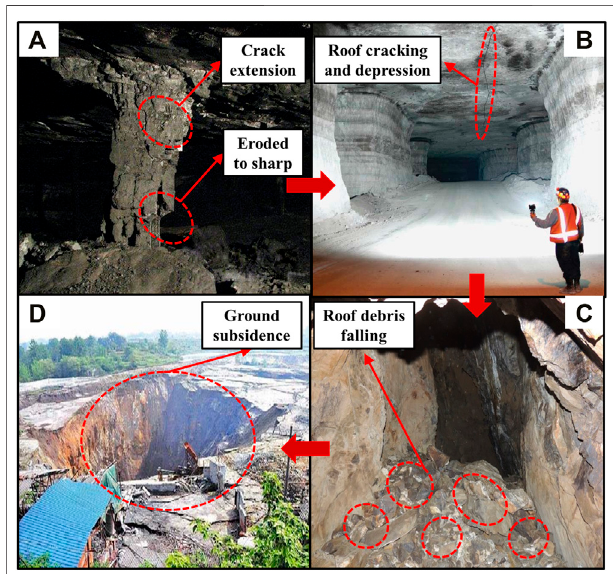
FIGURE 1 | Hydration and erosion of pillars under deep and high- humidity actions (Dunning et al., 1994): (A) Pillar instability; (B) Mine room Deformation; (C) Rockfall on the roof; (D) Land